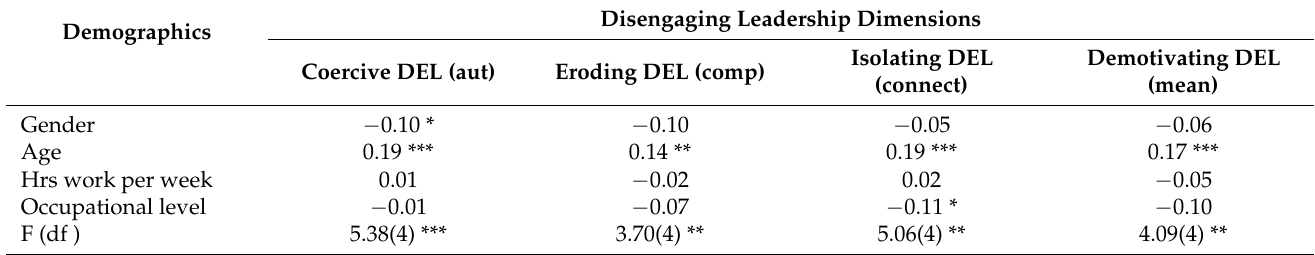
Table 5. Summary of Regression Analyses: Standardized Regression Coefficients ( N = 400). Disengaging Leadership Demographics